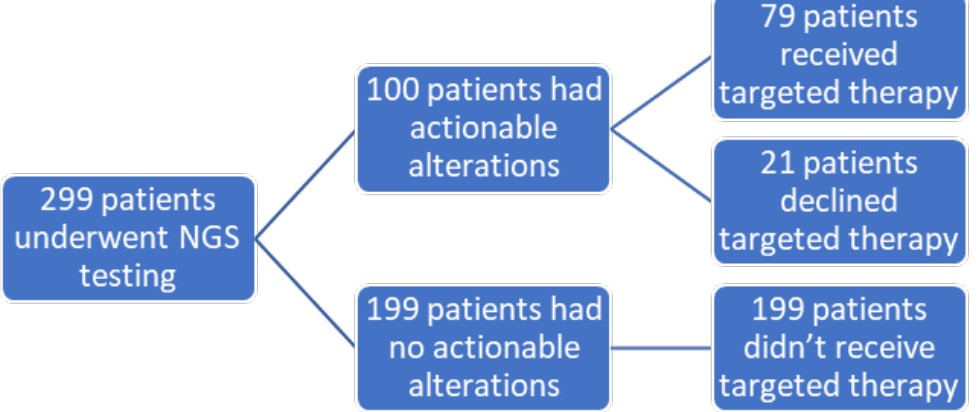
Figure 2. A diagrammatic representation of our study population who received targeted therapy based on NGS testing.